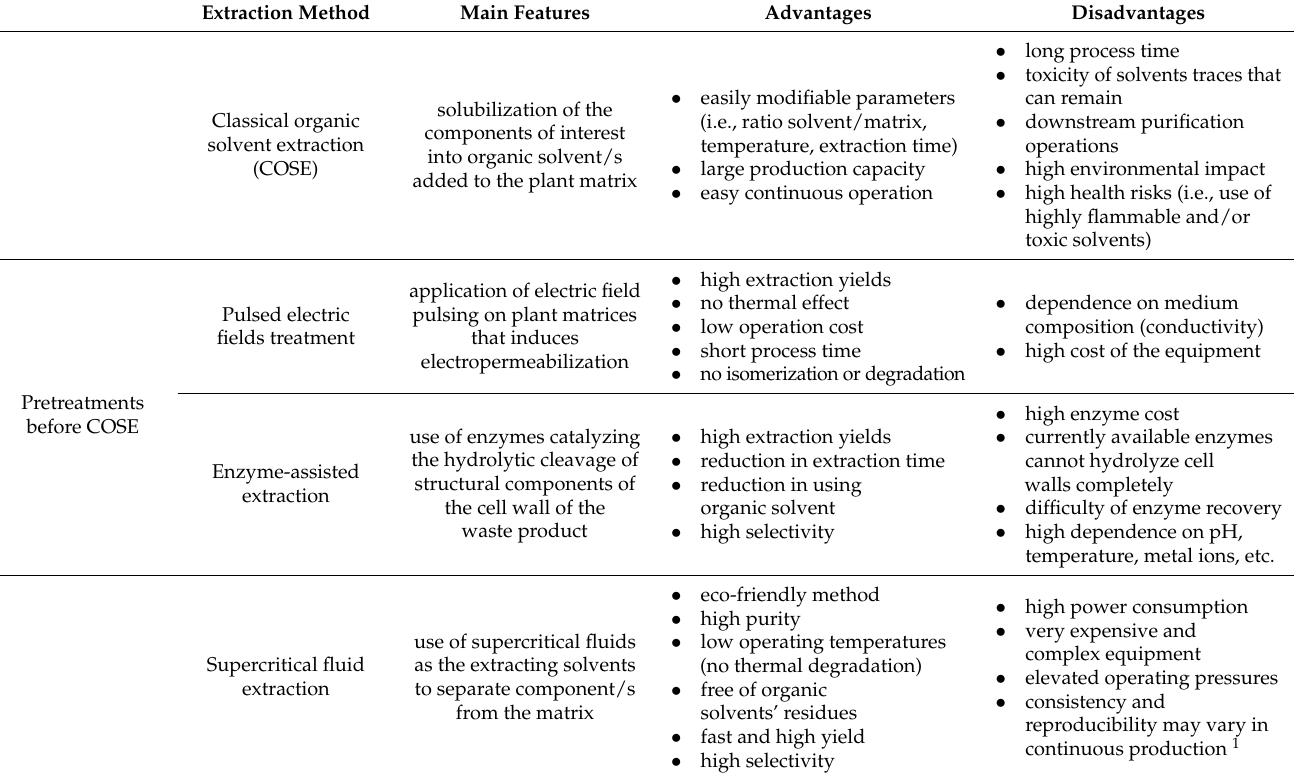
Table 1. Extraction methods for recovering lycopene from TBPs: advantages and disadvantages. Extraction